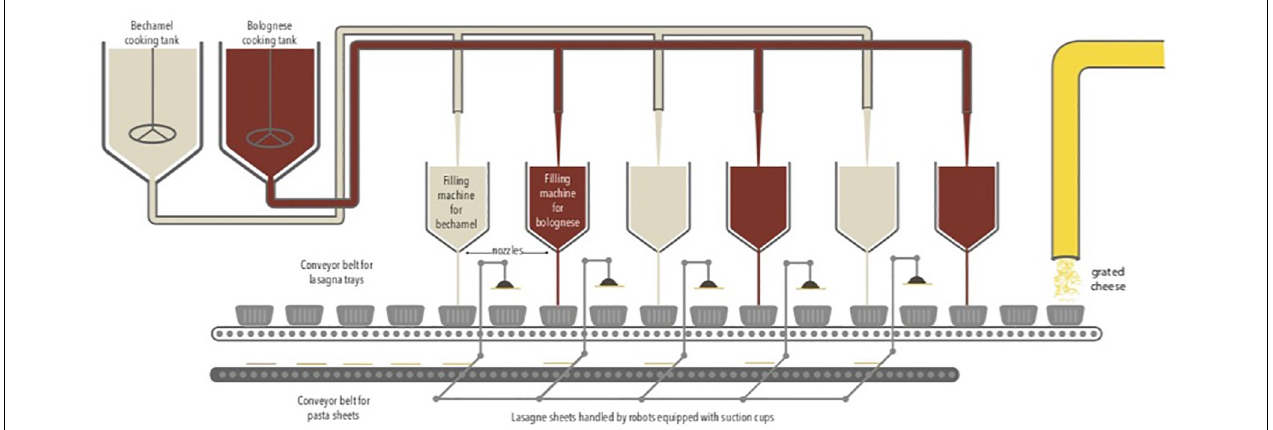
FIGURE 1 | Food production chain of